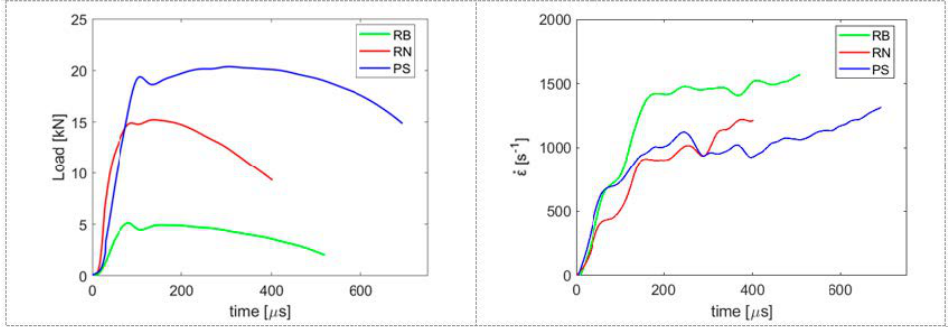
Figure 7. Load vs. time and engineering strain rate vs. time for three different specimen geometries tested at high strain rates.